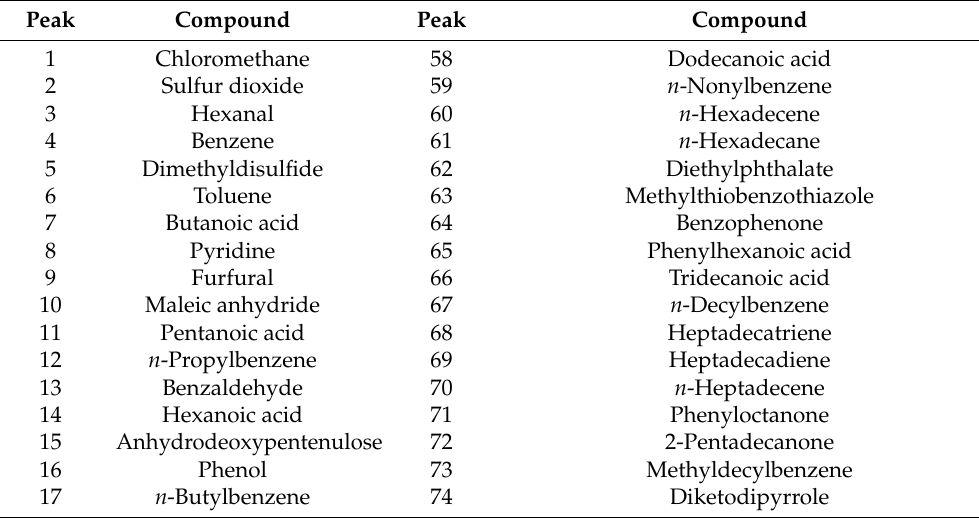
Figure 2. Untreated and acid hydrolyzed Ochroconis lascauxensis melanin pyrolyzed at 300 ◦ C. Peaks refer to Table 2. Table 2. Pyrolysis products obtained in the pyrolysis at 300 ◦ C of the untreated and acid hydrolyzed Ochroconis lascauxensis